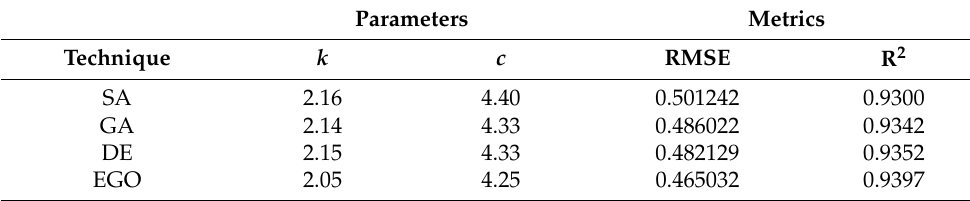
Table 6. Performance comparison and parameter estimation for yearly